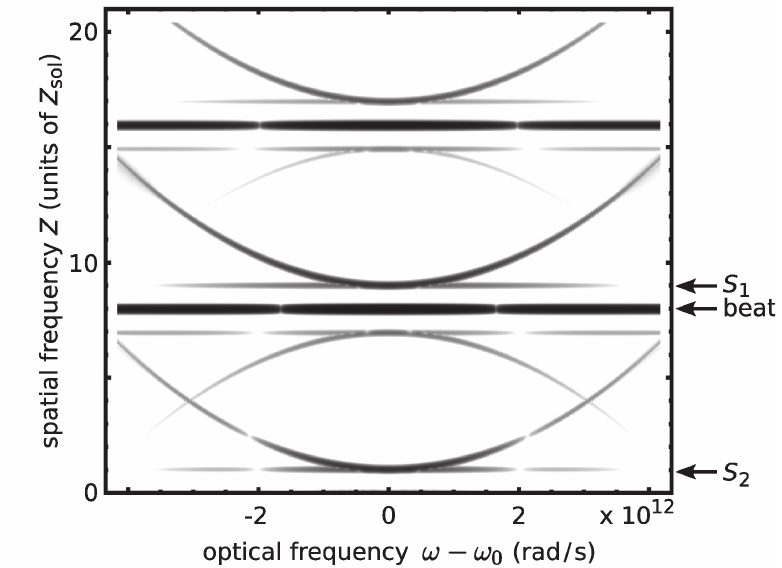
Figure 12. Full-frequency SRBA chart to determine the soliton content of an N = 2 soliton. Grey scale corresponds to the log of the Fourier transform of the spatial evolution of the spectral power density. Arrows labeled S 1 and S 2 mark traces pertaining to the first and second soliton; their beat note is also highlighted (from [93]).